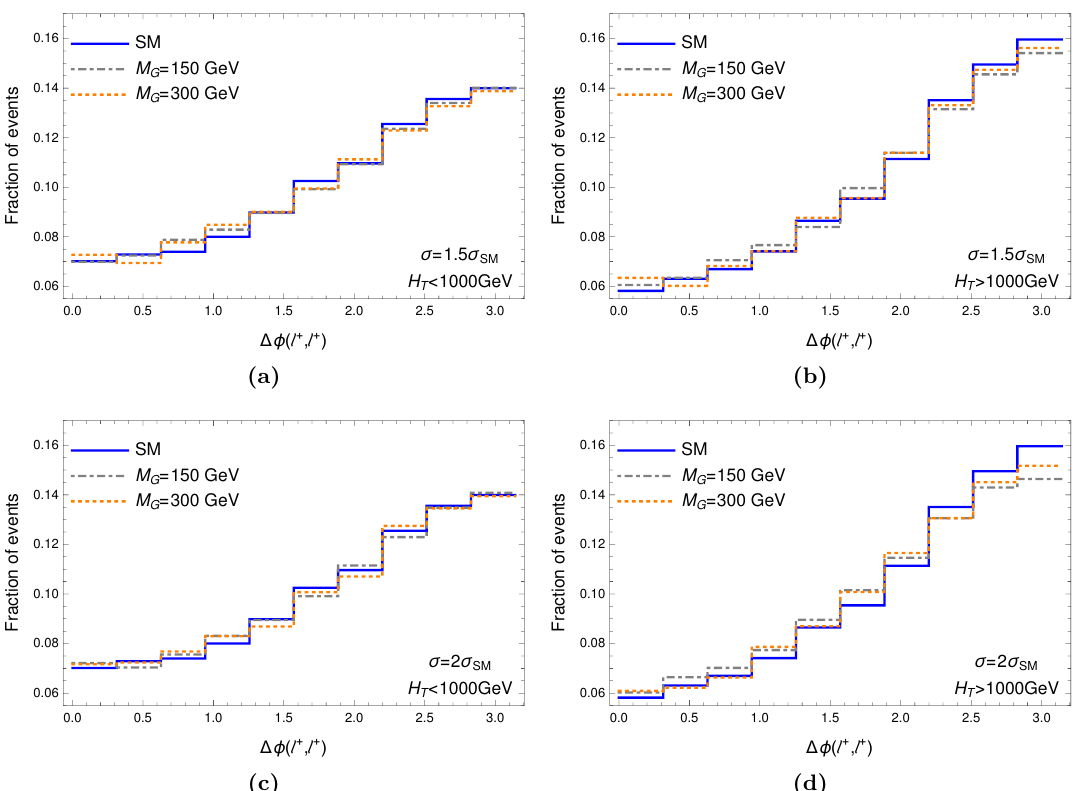
Figure 14. Distribution of the azimuthal separation between the same-sign leptons, (cid:1) (cid:30) ( ‘ + ; ‘ + ), for the 2LSS channel after preselection (see text for details) with (left) H T < 1000 GeV and (right) H T > 1000 GeV, normalized to unit area. Shown are the predictions for the SM (blue) and the Graviton model for (a, b) the tight benchmark points (i.e. giving (cid:27) = 1 : 5 (cid:27) SM ) and (c, d) the loose benchmark points (i.e. giving (cid:27) = 2 (cid:27) SM ).